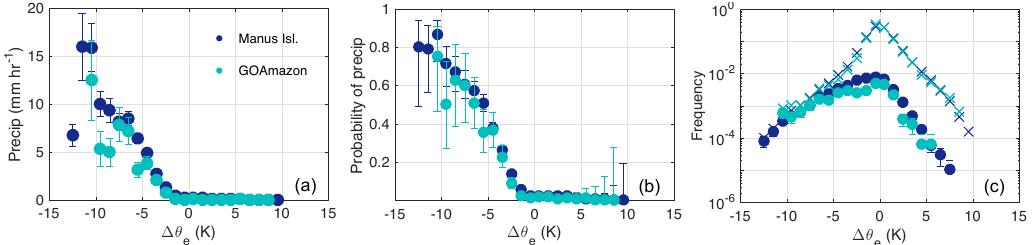
Figure 8. Same as Fig. 7, except comparing results from in situ data only at the GoAmazon2014/5 site (aqua) and the DOE ARM site at Manus Island (navy blue).